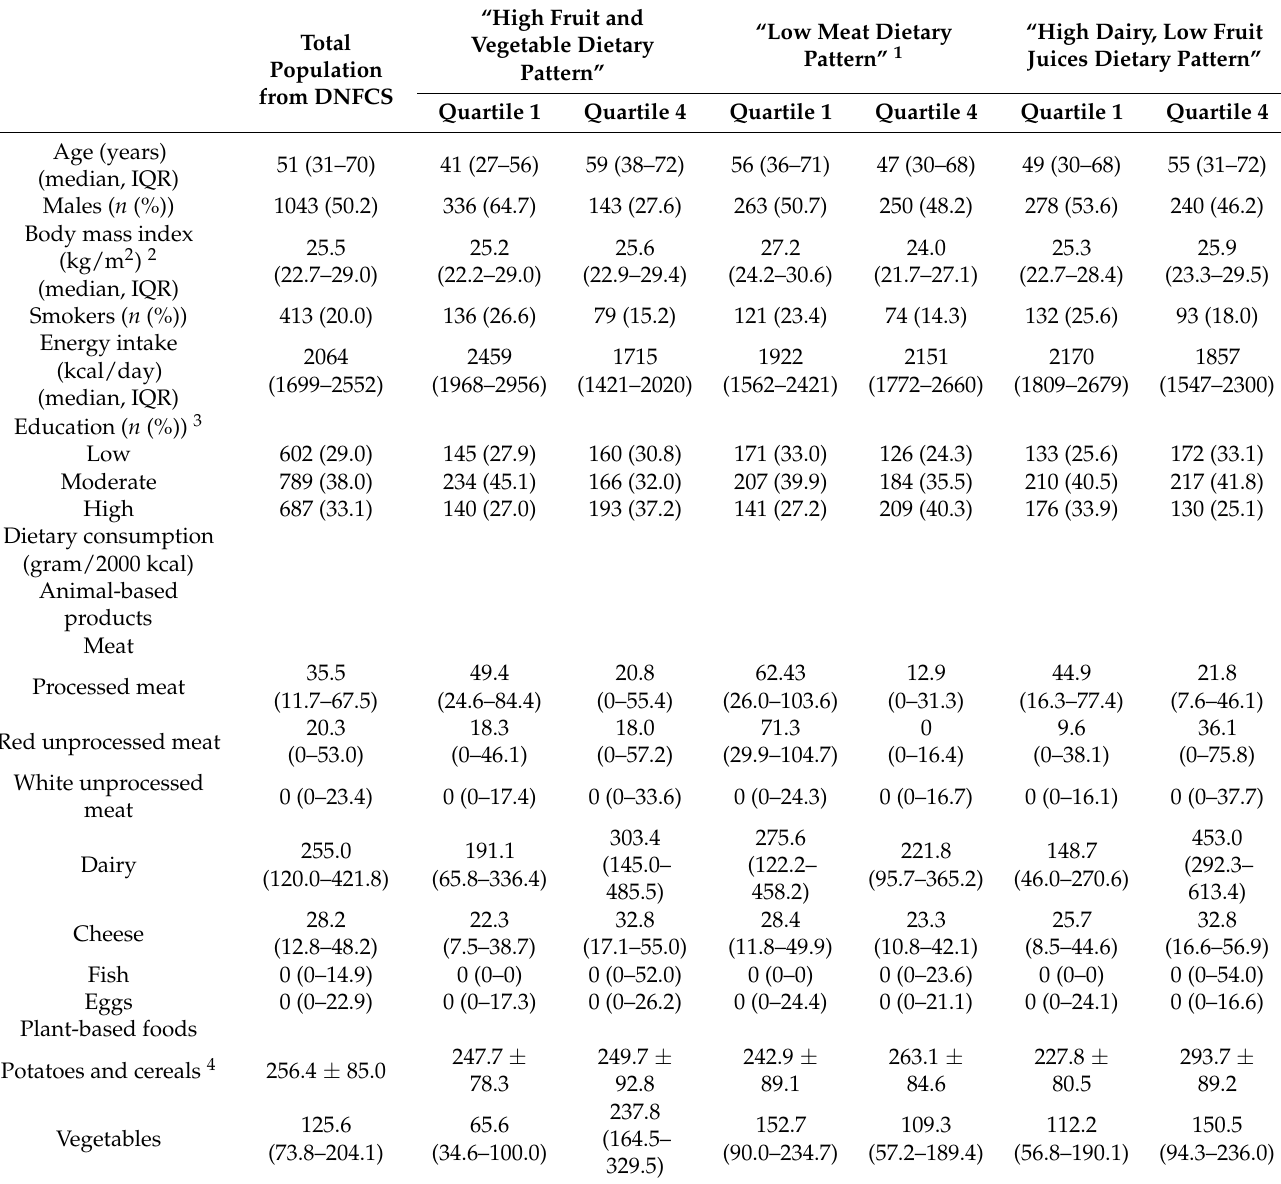
Table 1. Characteristics and consumption (g/2000 kcal) per food group of the total adult population ( n = 2078) and diets in quartile one and four of the “high fruit and vegetable dietary pattern”, the “low meat dietary pattern”, and the “high dairy, low fruit juices dietary pattern”, derived by the reduced rank